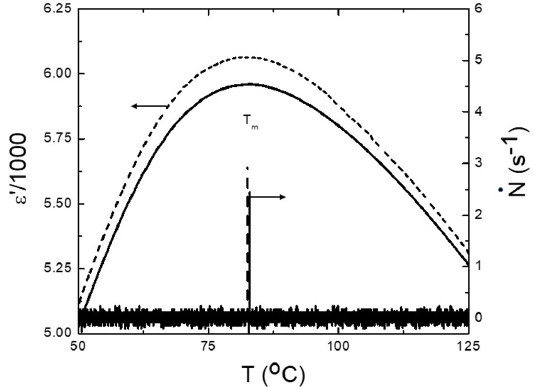
Figure 3. A plot of the real part ε′ of the dielectric constant and the AE count rate, N  (s -1 ), of 9/65/35 PLZT ceramics. Table 1. Comparison of the Eth s in PMN- x PT and x /65/35 PLZT relaxor ferroelectrics.